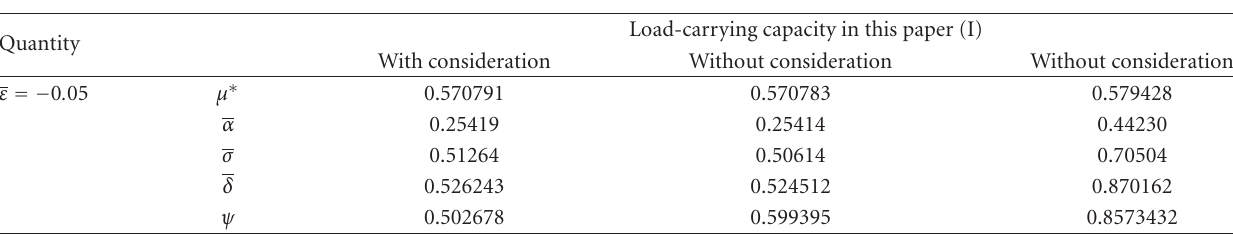
Load-carrying capacity in this paper (I) Quantity With consideration Without consideration Without